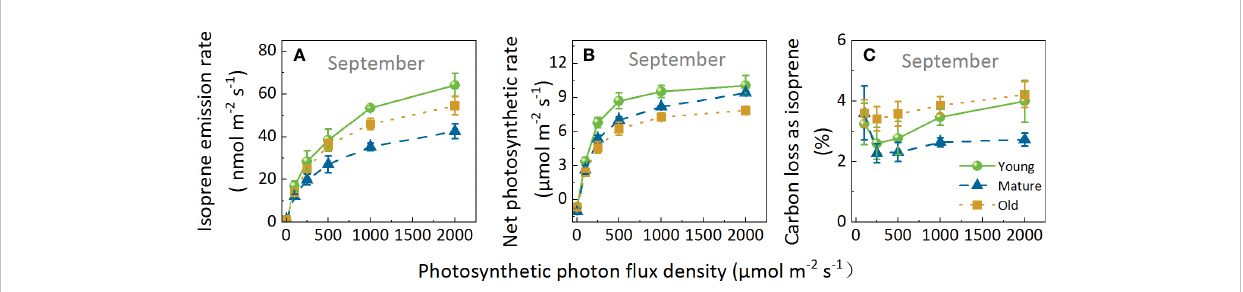
FIGURE 4 Isoprene emission rate (A) , net photosynthetic rate (B) , and percentage of carbon loss as isoprene (C) of Moso bamboo leaves in response to light intensity. During the measurements for light response, leaf temperature was set to 30°C, and ambient CO 2 concentration to 400 m mol mol -1 . Data are means ( ± SE), n=4 – 6.